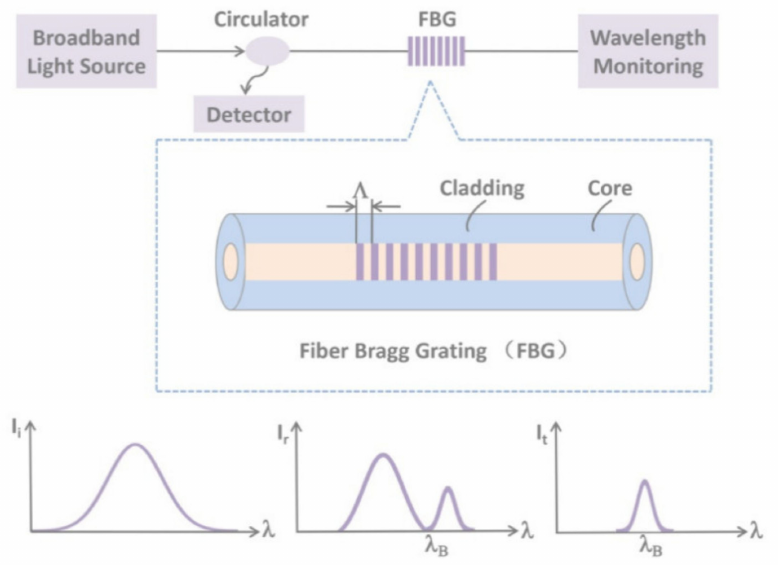
Figure 6. FBG sensor